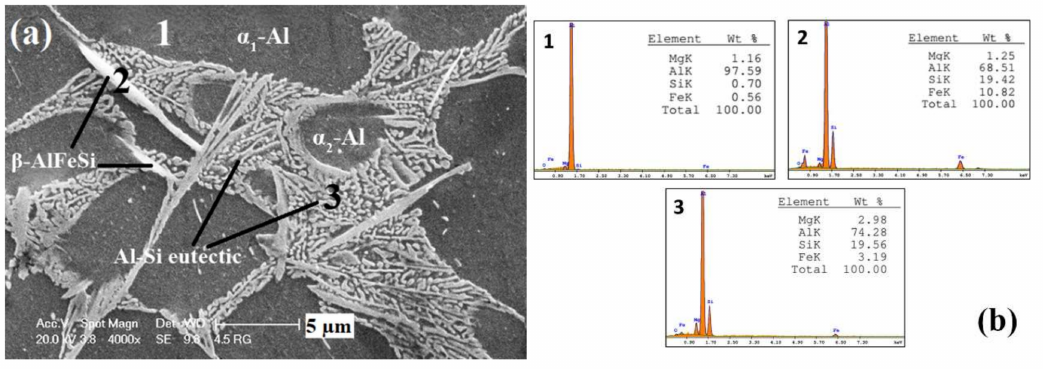
Figure 7. SEM image ( a ) and spot EDS analysis ( b ) of polished surface microstructure of the sample 4.5